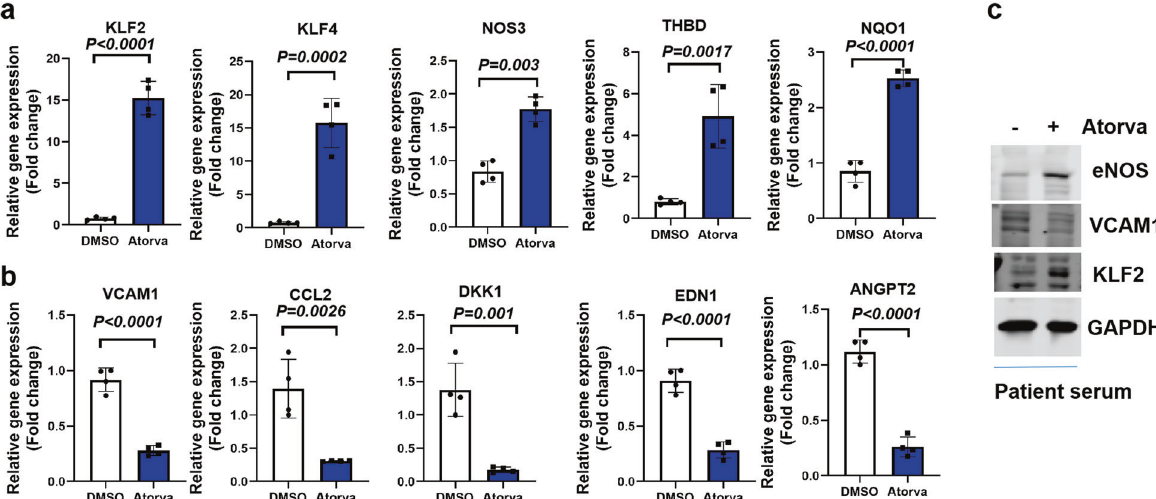
Fig. 4 Atorvastatin regulates the expression of genes and proteins relevant to endothelial dysfunction in endothelial cells exposed to patient serum. a HUVECs were treated with vehicle (0.1% DMSO) or Atorvastatin (10 µM in 0.1%DMSO) for 24 h in the presence of COVID-19 patient serum before RNA was collected for real-time PCR analysis of gene expression. Genes related to vascular homeostasis and anti-thrombosis (KLF2, KLF4, NOS3, and Thbd) and antioxidant status (NQO1) were presented as fold changes over control. N = 4. b HUVECs were treated as described in a , and expression of genes related to in fl ammation (VCAM1, CCL2, and DKK1), vascular tone (EDN1 or ET1), and angiogenesis (ANGPT2) were presented as fold changes over control. N = 4. c HUVECs were treated as described in a before whole-cell lysate was collected for western blot to determne protein expression of eNOS, VCAM1, and KLF2 using GAPDH as the loading control. N =